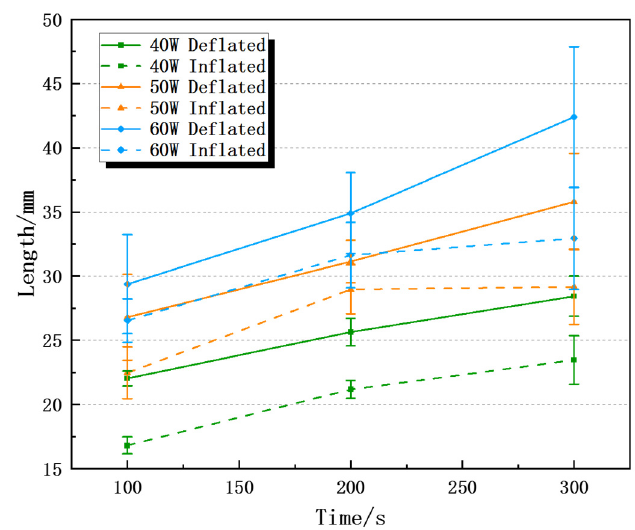
Figure 6. Average short diameter.